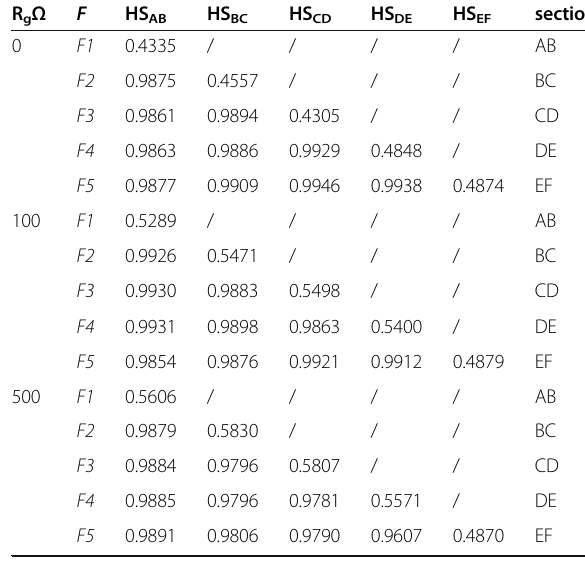
Table 6 Results of the proposed positioning method ( φ = 30 ∘ , ungrounded system)